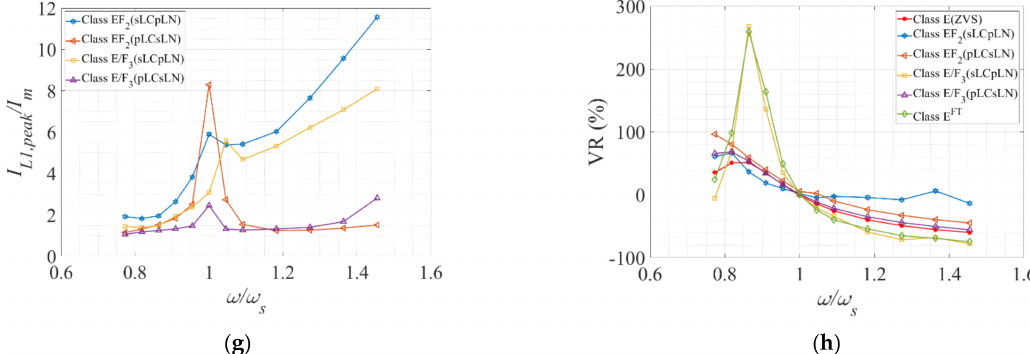
Figure 7. ( a ) The power output capability ( c p ); ( b ) efficiency ( η ); ( c ) the normalized peak switch voltage ( V S1,peak / V in ); ( d ) the normalized peak switch current ( I S1,peak / I m ); ( e ) the normalized peak resonant capacitor voltage ( V cs,peak / V in ); ( f ) the normalized peak auxiliary resonant capacitor voltage ( V C 1 ,peak / V in ); ( g ) the normalized peak auxiliary resonant current ( I L 1 ,peak / I m ); ( h ) voltage regulation in percentage against normalized switching frequency ( ω / ω s ) at f s = 220 kHz, D = 0.50 (E), 0.40 (EF 2 ,E/F 3 ) k ≈ 0.30 (EF 2 ) and 0.67 (E/F 3 ).